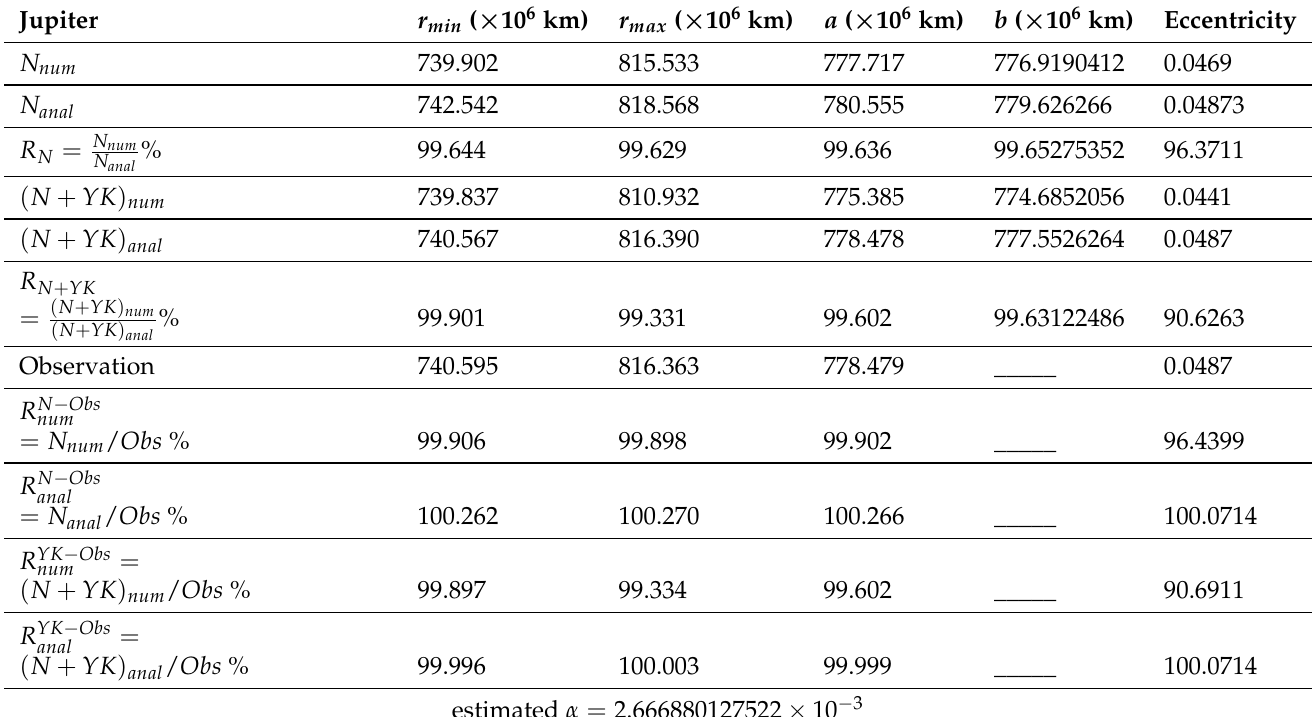
Table A10. The values of the calculated and observational astronomical parameters, for estimated α , of the planet Jupiter, whose number of moons is 0.